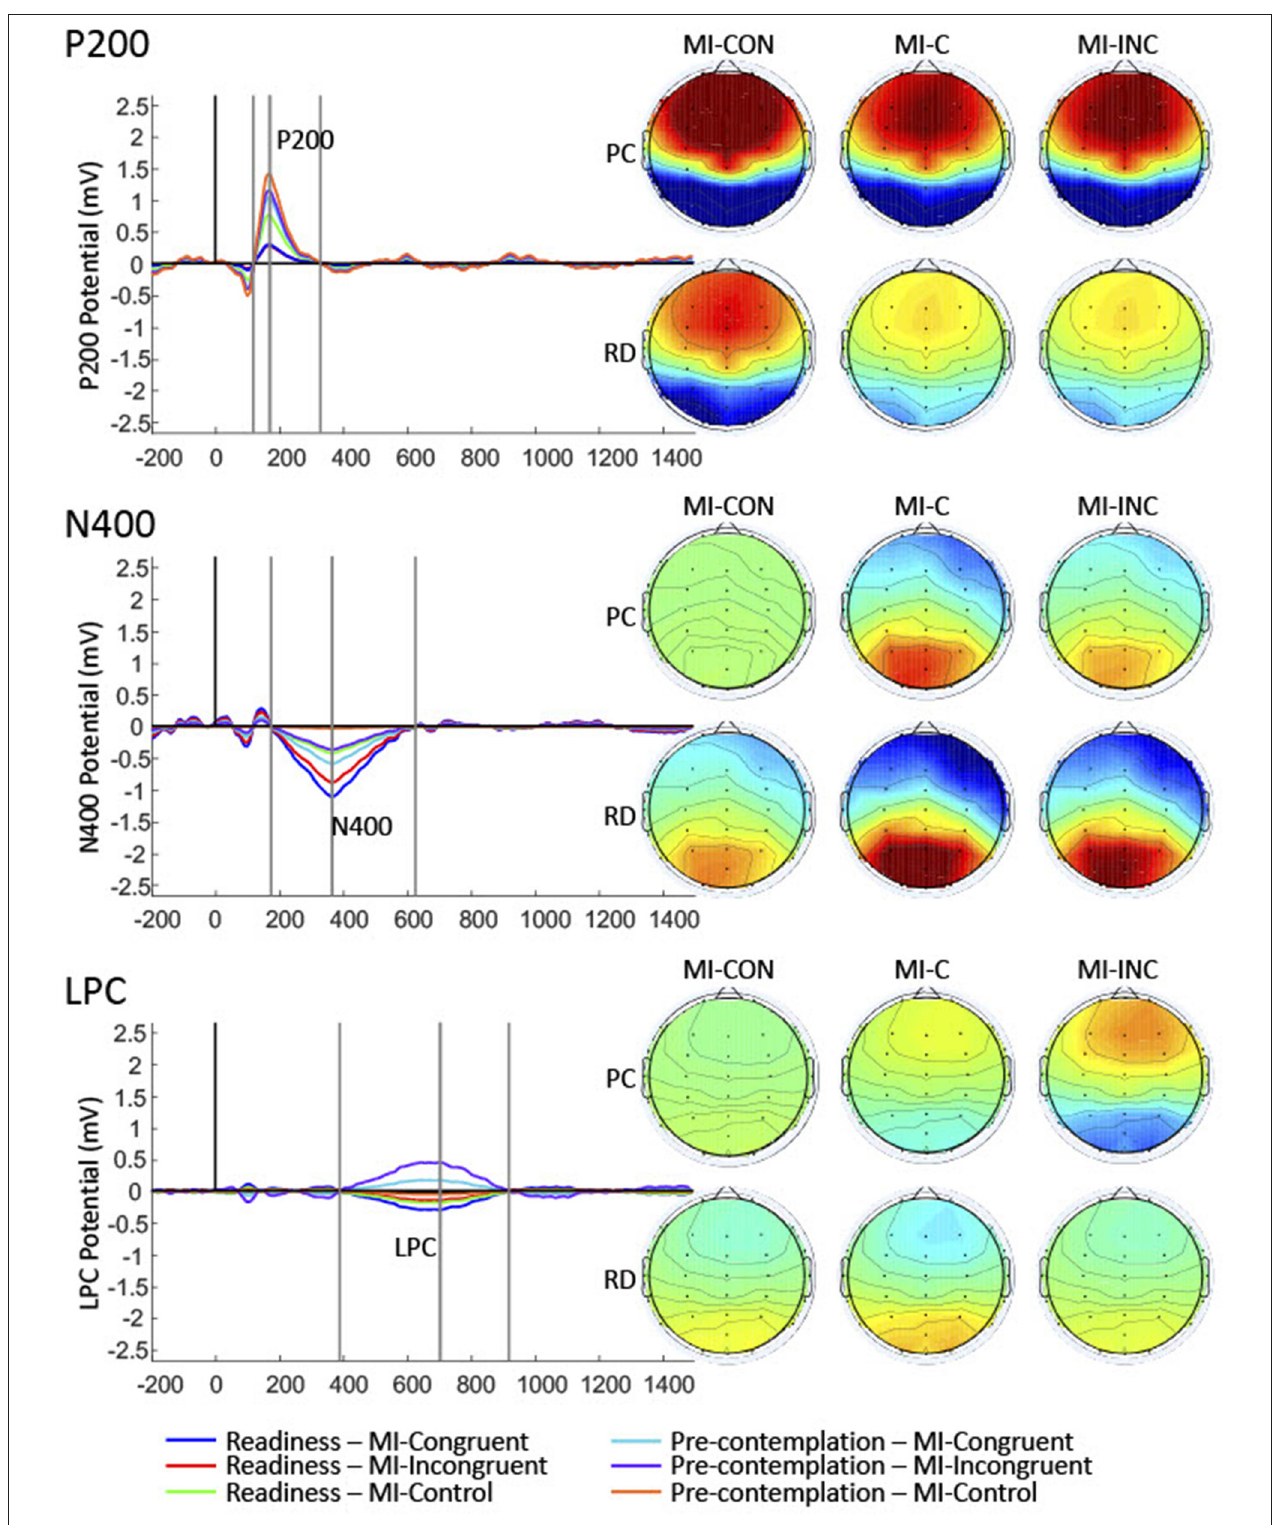
FIGURE 4 | The topography and latency of the P200, N400, and LPC components. The first spatial component of each of the temporal components were then identified. Grand average of the selected temporal-spatial components for each of the conditions were calculated and showed.